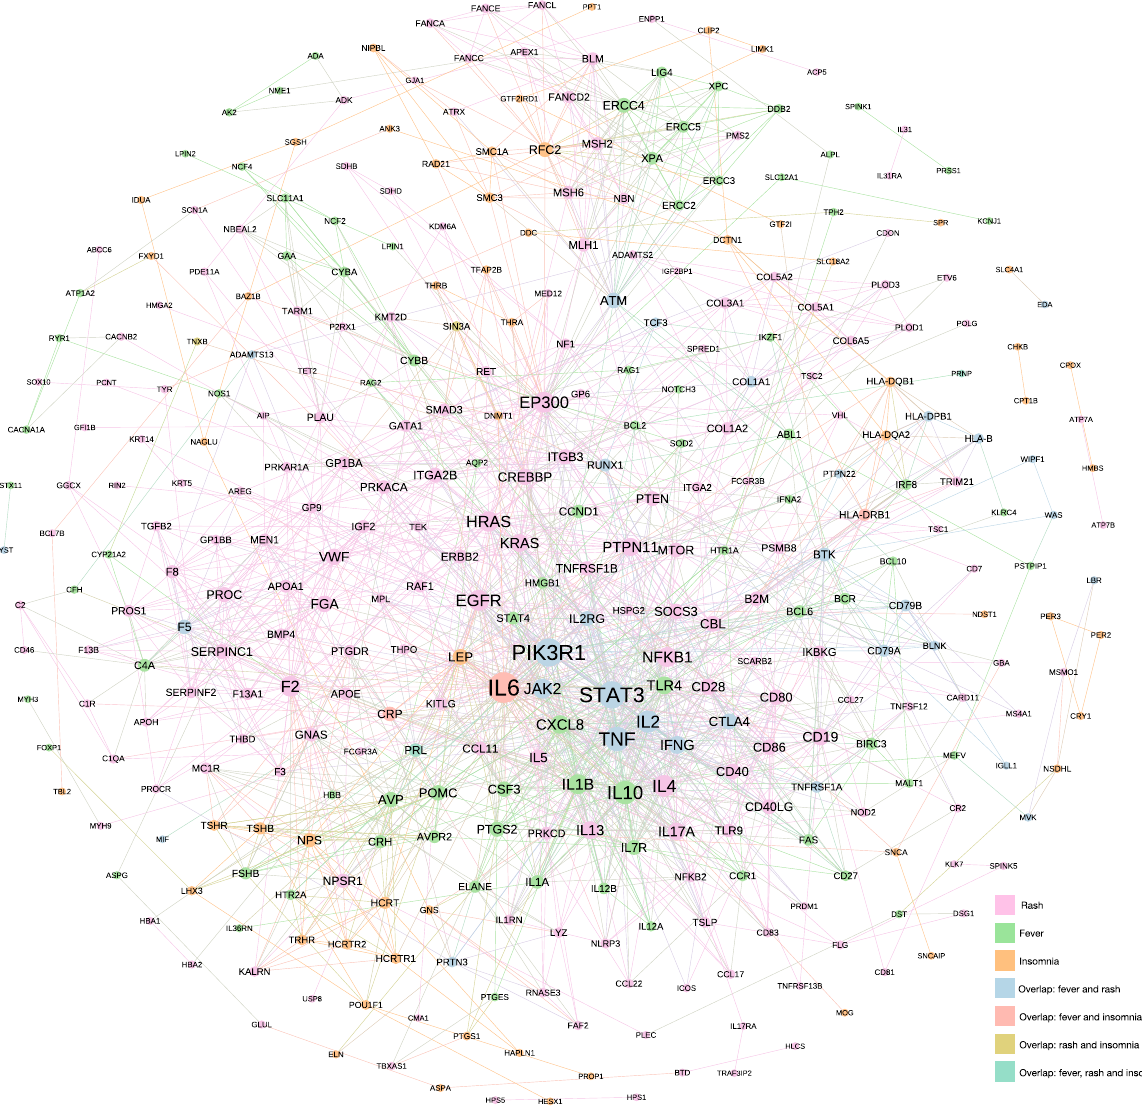
Fig. 7 Construction the PPI network of insomnia-fever-rash cluster. We extracted a PPI subnetwork of insomnia-fever-rash symptom clusters which consisted of 363 nodes and 1860 edges. The nodes indicate the related genes of these symptoms in PPI network and edges represent the interactions of these genes in PPI network. Node size re fl ected the degree of symptom in the network (a high degree is represented by large node). Node colors represent genes associated with different